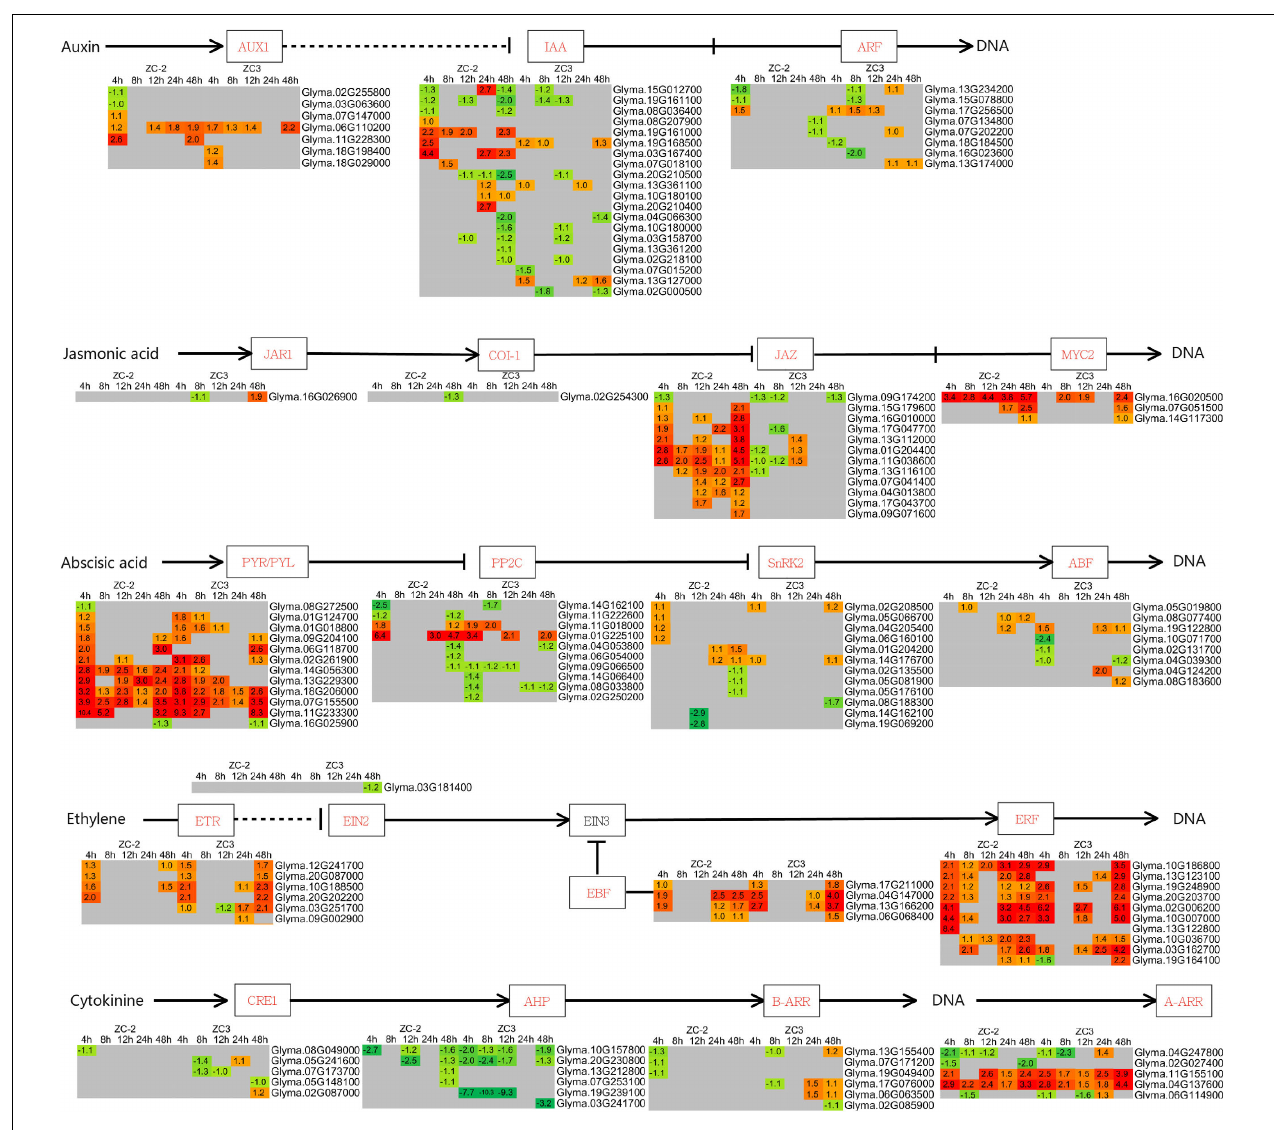
FIGURE 6 | Schematic diagram of plant hormone signaling pathways together with heatmaps of the associated differentially expressed genes (DEGs). The log 2 expression fold change is color-coded in each box: red indicates up-regulated DEGs and green indicates down-regulated DEGs. Each row represents a DEG with its gene ID; the columns represent each sampling time point [4, 8, 12, 24, and 48 h post-inoculation (HPI)] for ZC-2 and